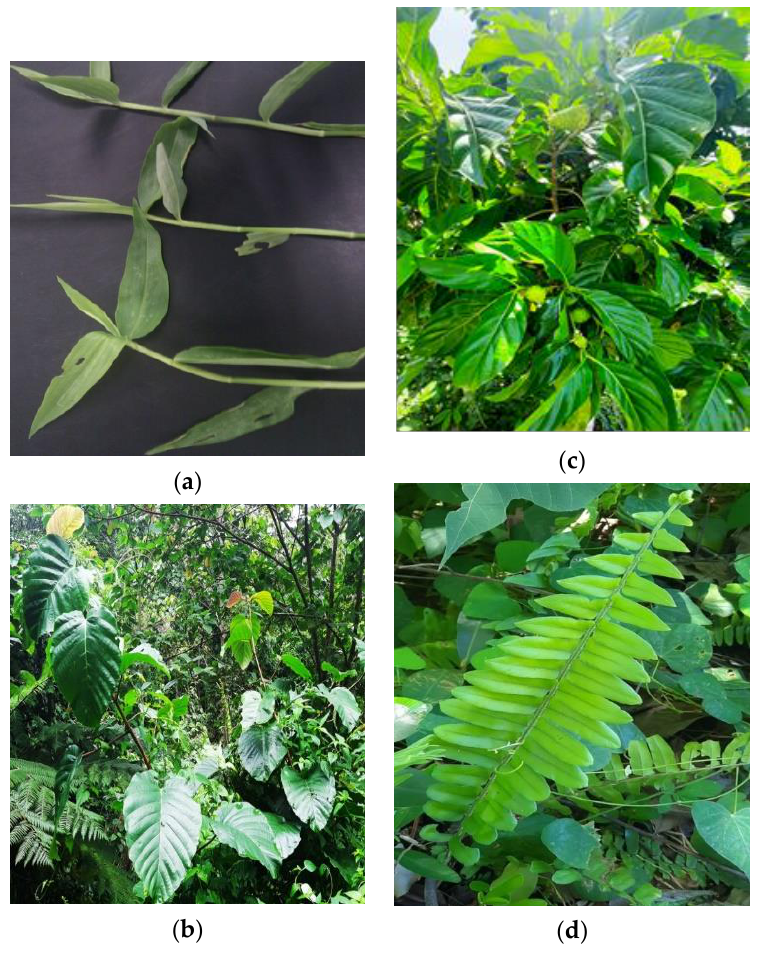
Figure 2. ( a ) Commelina Nudiflora : its leaves measure 7 – 10 cm in length and 1 – 2.5 cm in width, and its stalks are 35 – 60 cm in length. ( b ) Dillenia suffruticosa : it is usually 4 – 10 m tall with alternate, oval, penniveined, and serrated leaves. The young leaves are reddish, whereas the mature ones are dark green. ( c ) Morinda citrifolia : it reaches a height of 3 – 10 m at maturity and has light green, four-angled twigs with opposite, pinnately veined, and glossy leaves attached by stout petioles. ( d ) Nephrolepis biserrata : it is a tropical evergreen fern with pinnate, bipinnate, and palmate leaves and its leaves are usually 5 – 10 cm long and 2 – 5 cm wide and stalk range from 60 to 90 cm in length.